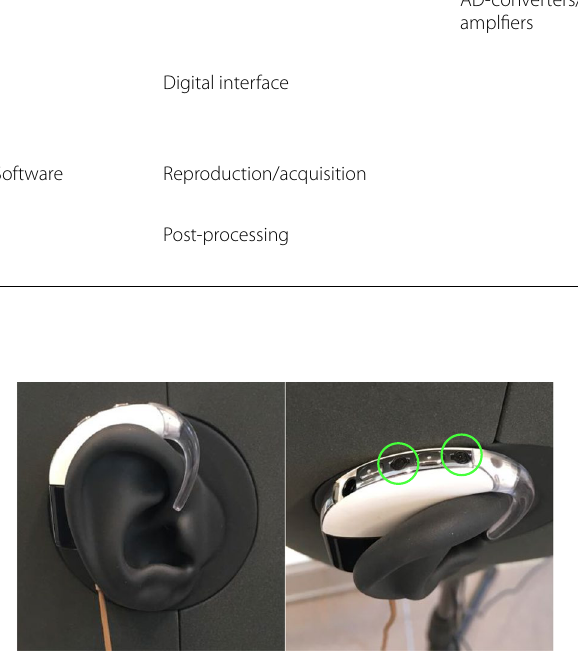
Fig. 2 Dummy BTE pieces used for creating the database. Each BTE piece consists of two omnidirectional microphones as indicated by the circles